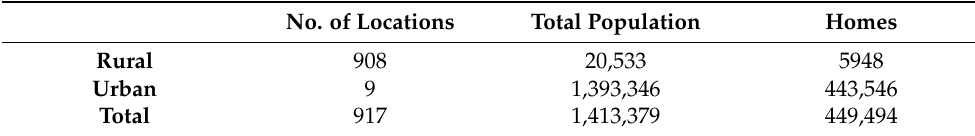
Table 6. Rural and urban localities within the study area.